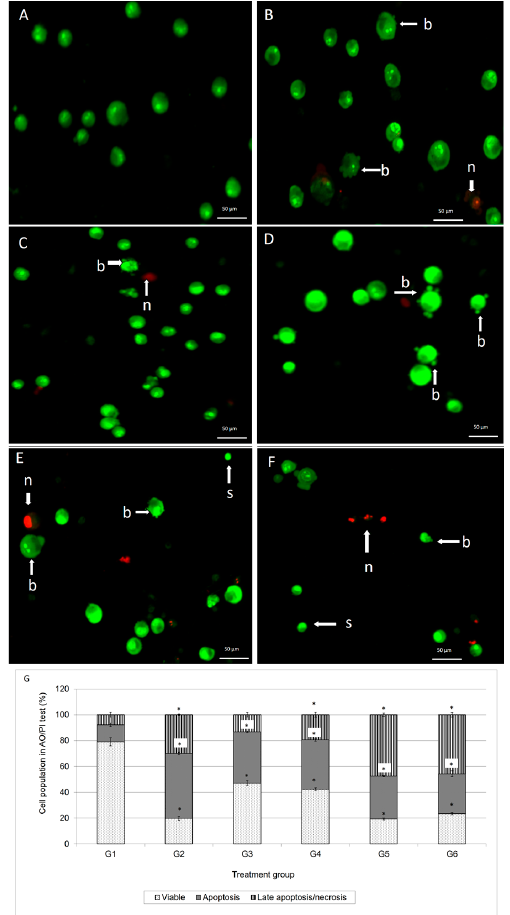
Figure 2. Fluorescent photomicrographs of MCF-7 cells treated with G1 ( A ); G2 ( B ); G3 ( C ); G4 ( D );